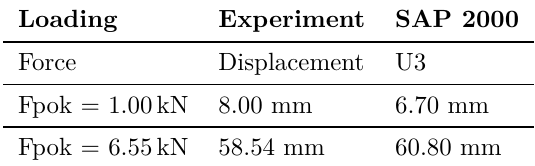
Table 2. Comparison of experimental and numerical displacement results.